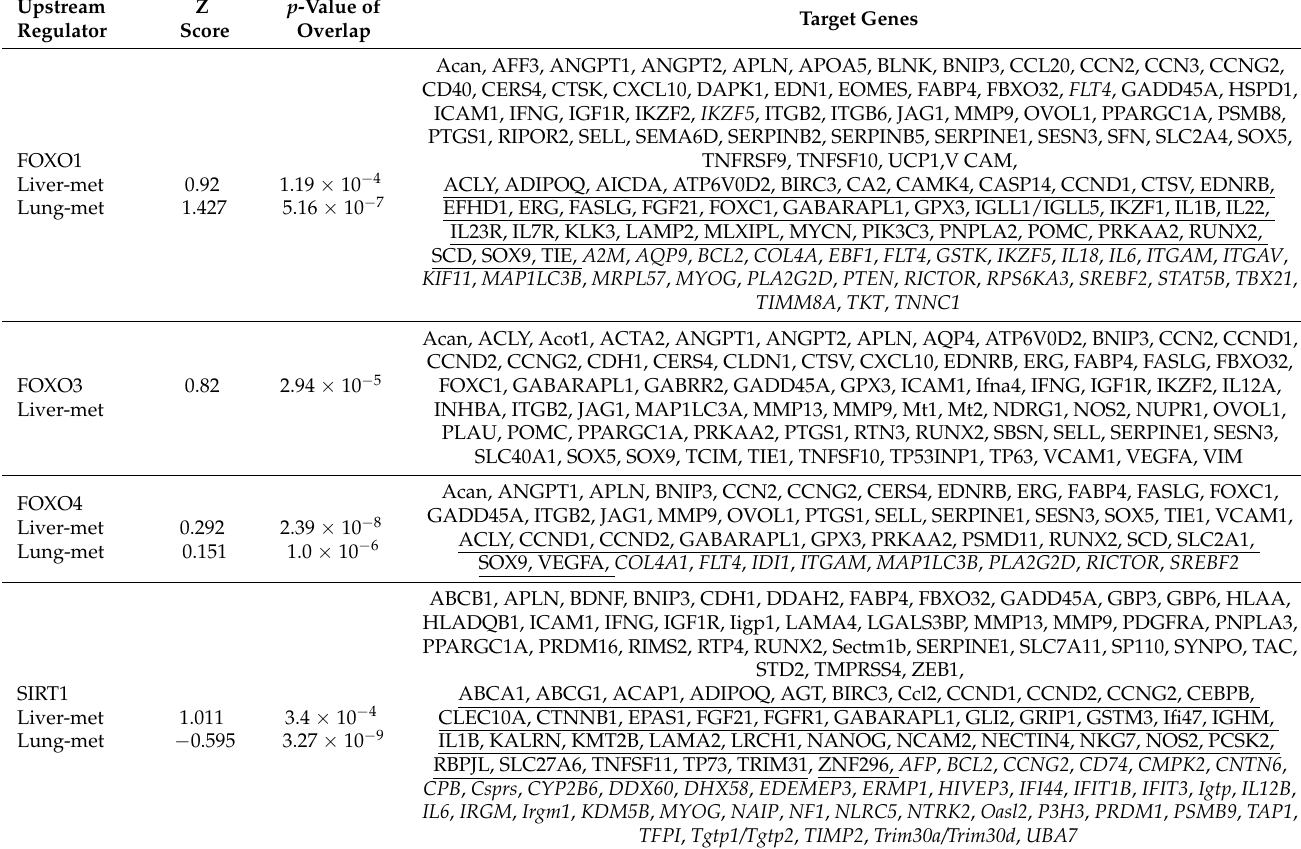
Table 1. Upstream regulators predicted to be activated or inhibited in liver and lung metastasis, with FDR p < 0.05, on the basis of known interactions compiled in the IPA (underlined gene names, targeted only in liver metastasis; italic gene names, targeted only in lung